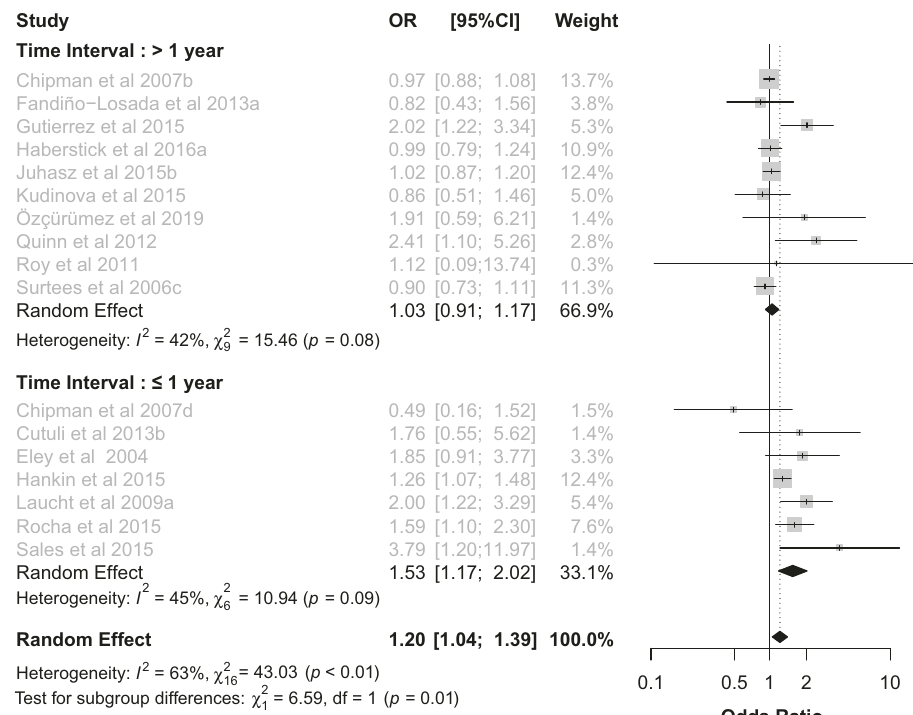
Fig. 3 Time interval between the end of the stress and the assessment of depression affects the 5-HTTLPR x stress interaction in chronic stress studies. Forest plot (OR and 95% CI) for 16 studies assessing the relationship between 5-HTTLPR, chronic stress and depression strati fi ed for time intervals (i.e. longer than 1 year, shorter than or equal to 1 year). The area of each square is proportional to the study weight in the analysis. The diamond represents pooled estimates from random-effects meta-analysis. Dashed line represents the overall effect. OR Odds Ratio, CI con fi dence